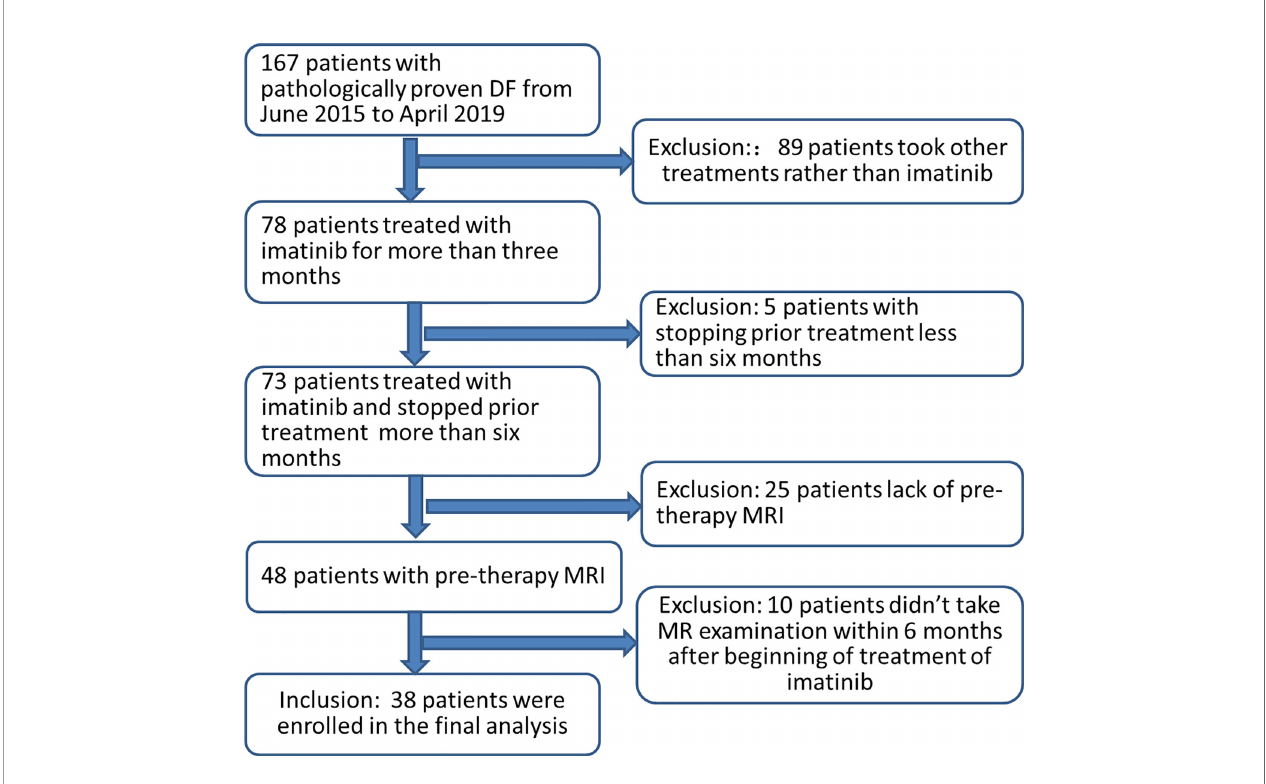
FIGURE 1 | Schematic of patient recruitment.